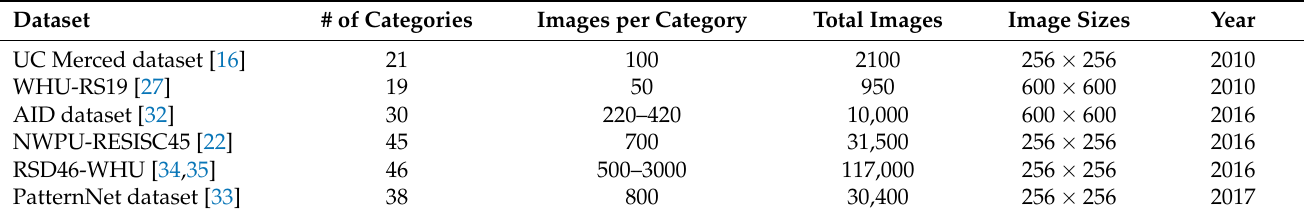
Table 1. Publicly available RS scene